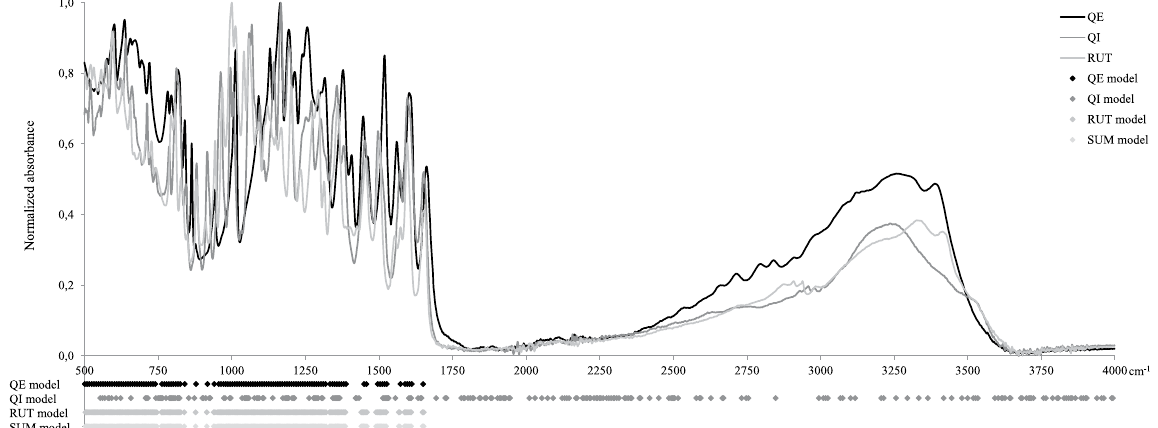
Figure 4. Spectra of quercetin (QE), quercitrin (QI) and rutin (RUT) and marked wavenumbers used in the models presented in Fig.